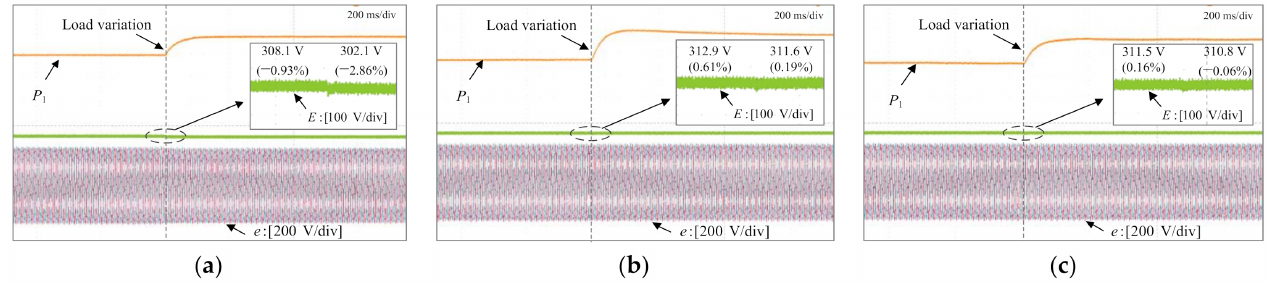
Figure 18. Experimental results of PCC voltage under load variations: ( a ) PCC voltage via conventional P-U/Q-f droop control method; ( b ) PCC voltage via PI-based P-U/Q-f droop control method; ( c ) PCC voltage via proposed TSMC-based P-U/Q-f droop control